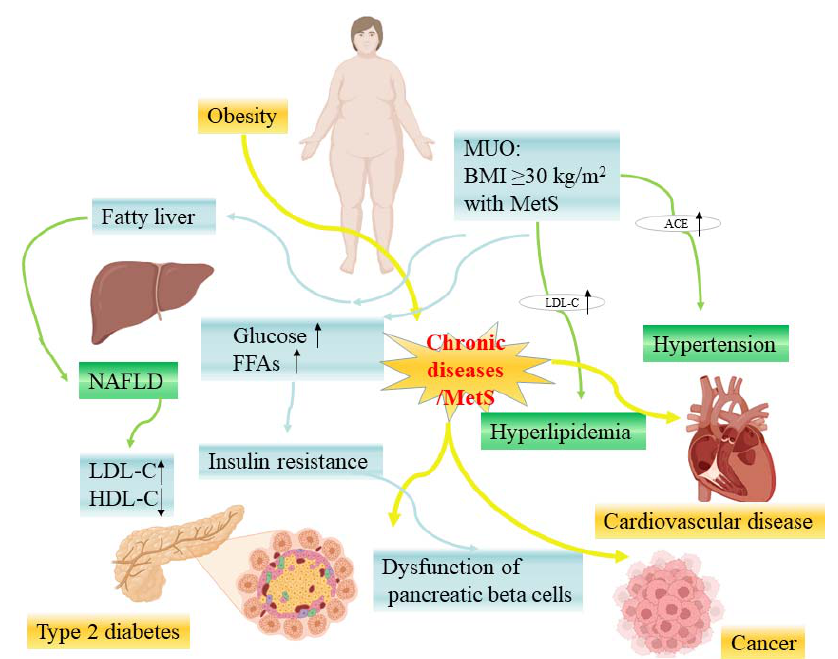
Figure 2. The relationship between chronic diseases and MetS-related diseases (some picture elements are from the BioRender). MUO—metabolic unhealthy obesity; NAFLD—nonalcoholic fatty liver disease; LDL-C—low-density lipoprotein cholesterol; HDL-C—high-density lipoprotein cholesterol; ACE—angiotensin-converting enzyme; FFAs—free fatty